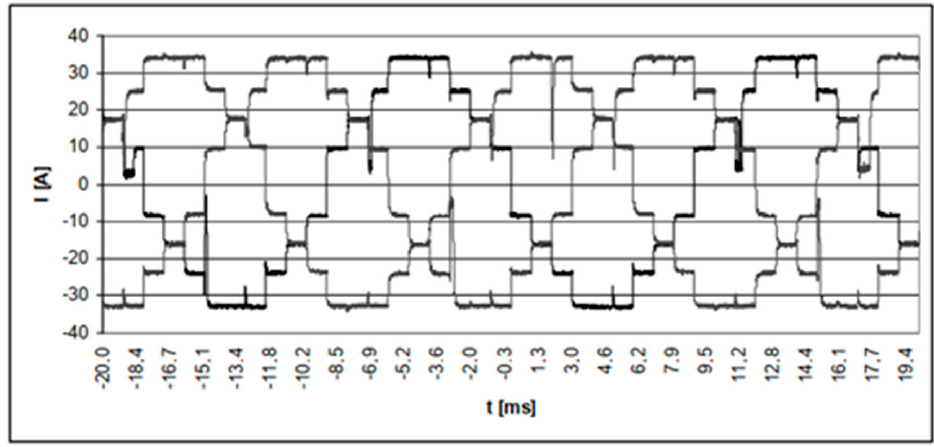
Figure 8. The phase current waveforms of the OVT converter gained during experimental tests.